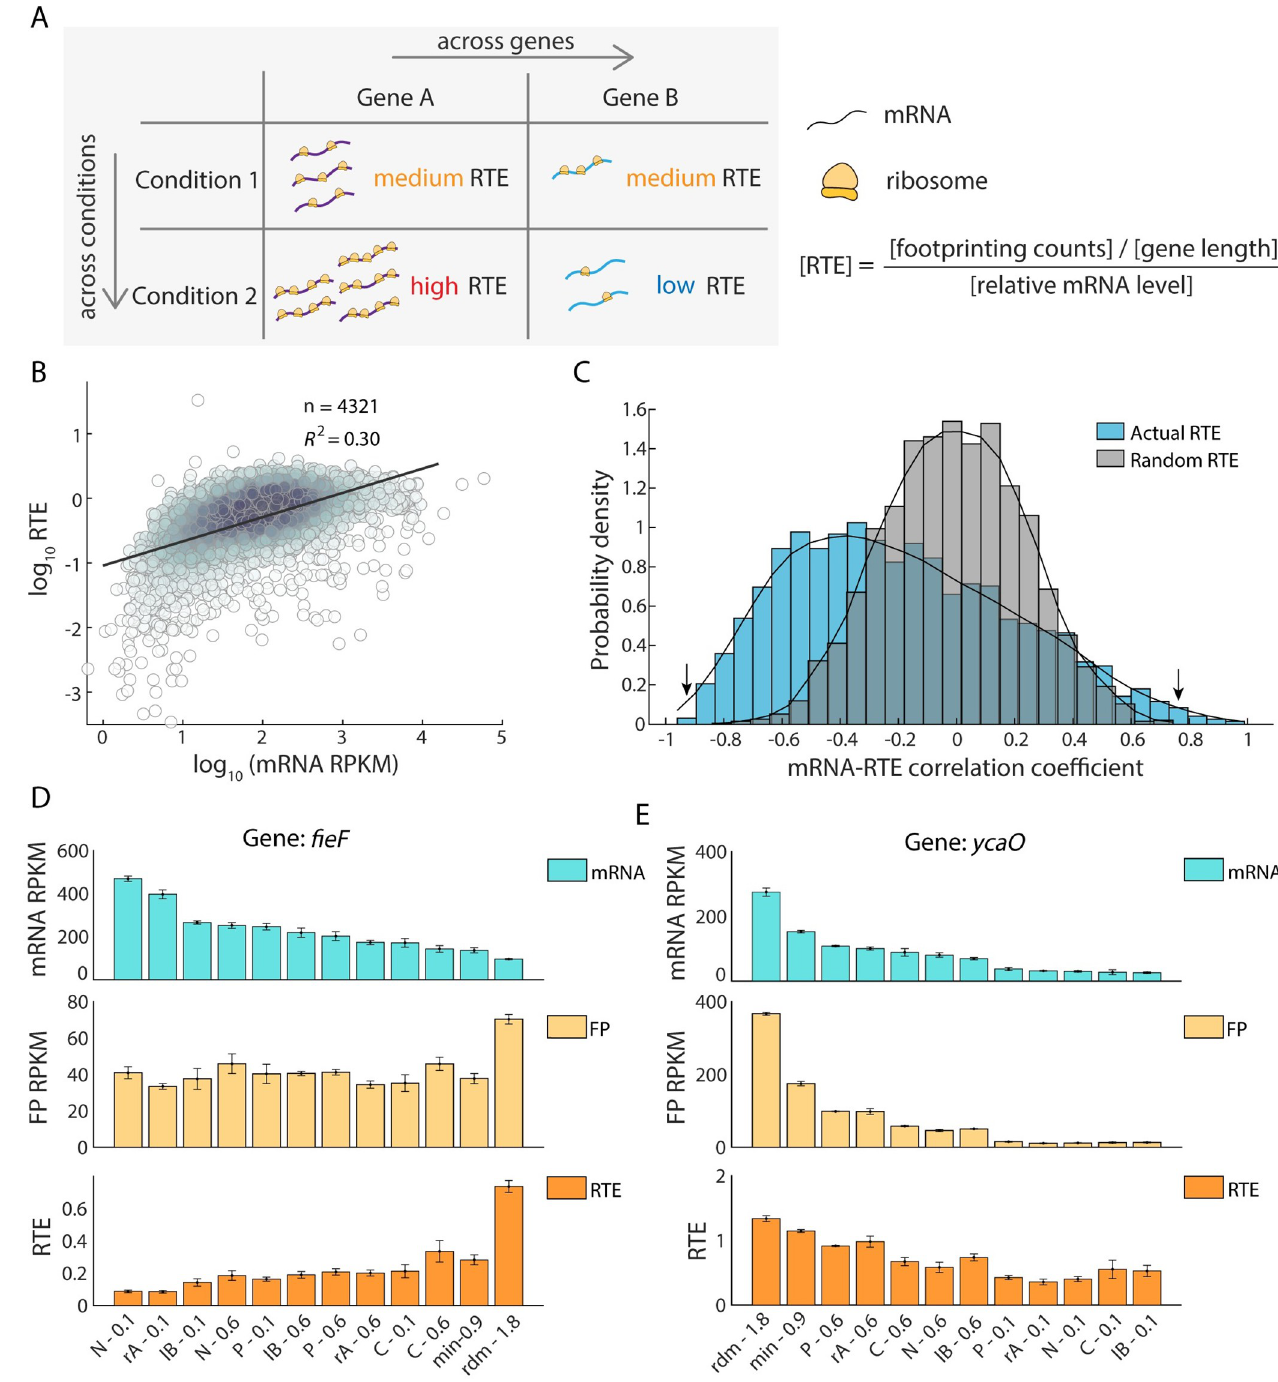
Fig 2. Global view of mRNA-Relative Translation Efficiency (RTE) correlations across genes and across conditions. (A) Two types of correlations between mRNA level and RTE: across genes and across conditions. (B) Correlation between mean mRNA level and mean RTE, across different genes. Mean levels were taken as the average of all 12 conditions (Table 1). Each dot represents one gene, and color depth depicts the density of points. (C) Distribution of Spearman’s rank correlation coefficients between mRNA level and RTE across the 12 different conditions. Each gene provides one such correlation coefficient, and distributions are shown for 2914 genes (blue bars–Actual RTE: original RTE from RNA-Seq and Ribosome profiling; gray bars–Random RTE: the RTE values for each gene were randomly scrambled among the 12 conditions to obtain the randomly ordered RTEs, which was considered as the null distribution, see methods and S1 Text for details). The p -value between the two distributions from Kolmogorov-Smirnov test was 5e-130. (D-E) Example of two genes with negative correlation (D, gene fieF , left arrow in B) and positive correlation (E, gene ycaO , right arrow in B) between their mRNA levels and RTEs. The mRNA